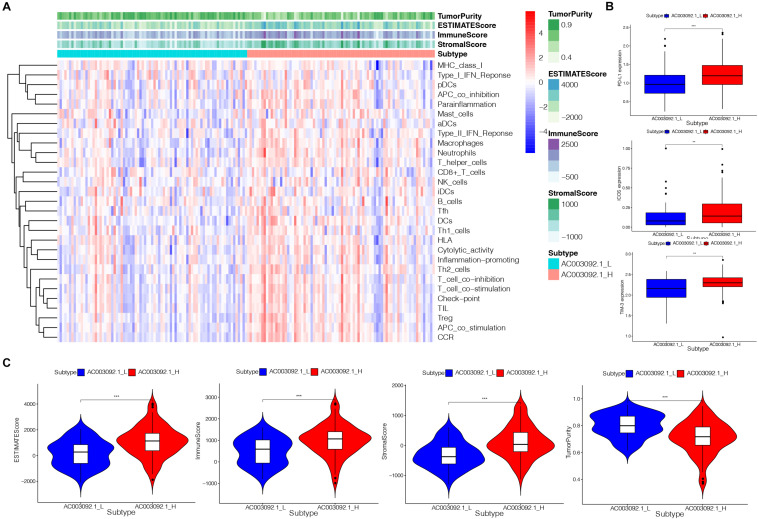
Immunogenomic analysis of AC003092.1_H and AC003092.1_L from TCGA. (A) The enrichment levels of the 29 immune signatures by ssGSEA score in each GBM sample. (B) Comparison of immune checkpoint gene expression levels between AC003092.1_H and AC003092.1_L (ANOVA test). (C) Comparison of the immune score, stromal score, ESTIMATE score, and tumor purity between AC003092.1_H and AC003092.1_L (Kruskal–Wallis test). *p < 0.05, **p < 0.01, ***p < 0.001.